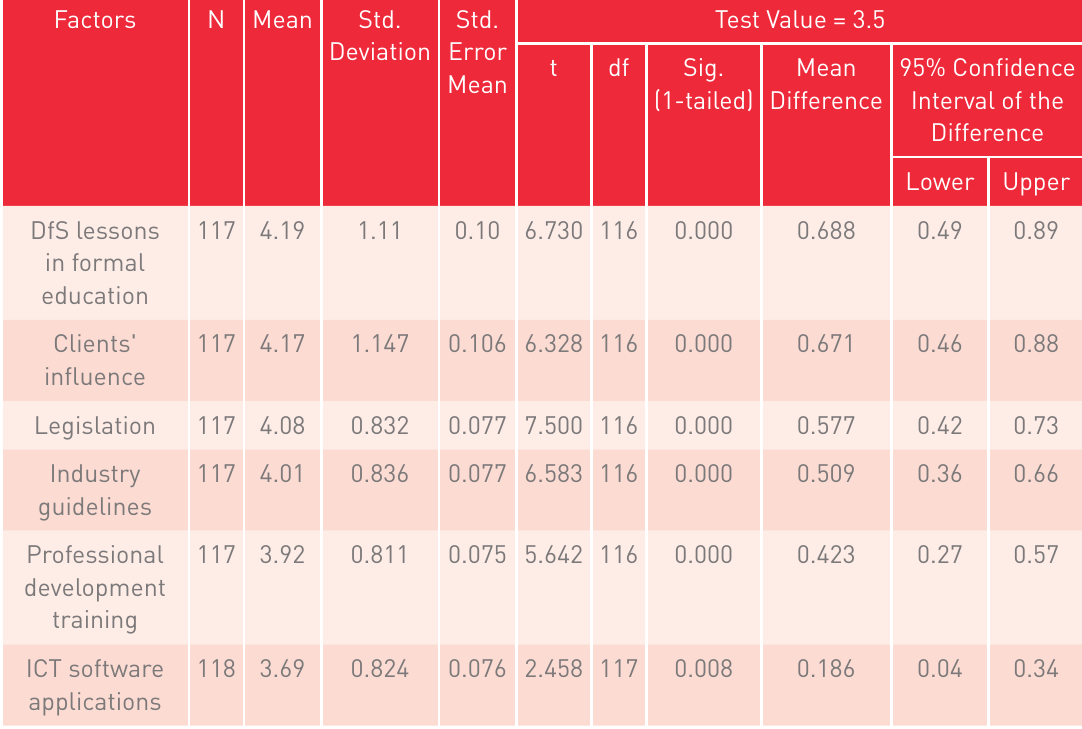
Table 5. One sample t-test for the factors affecting DfS